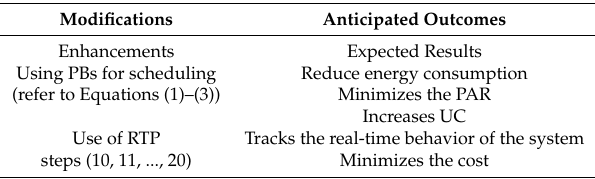
Table 8. Modifications in GWD.